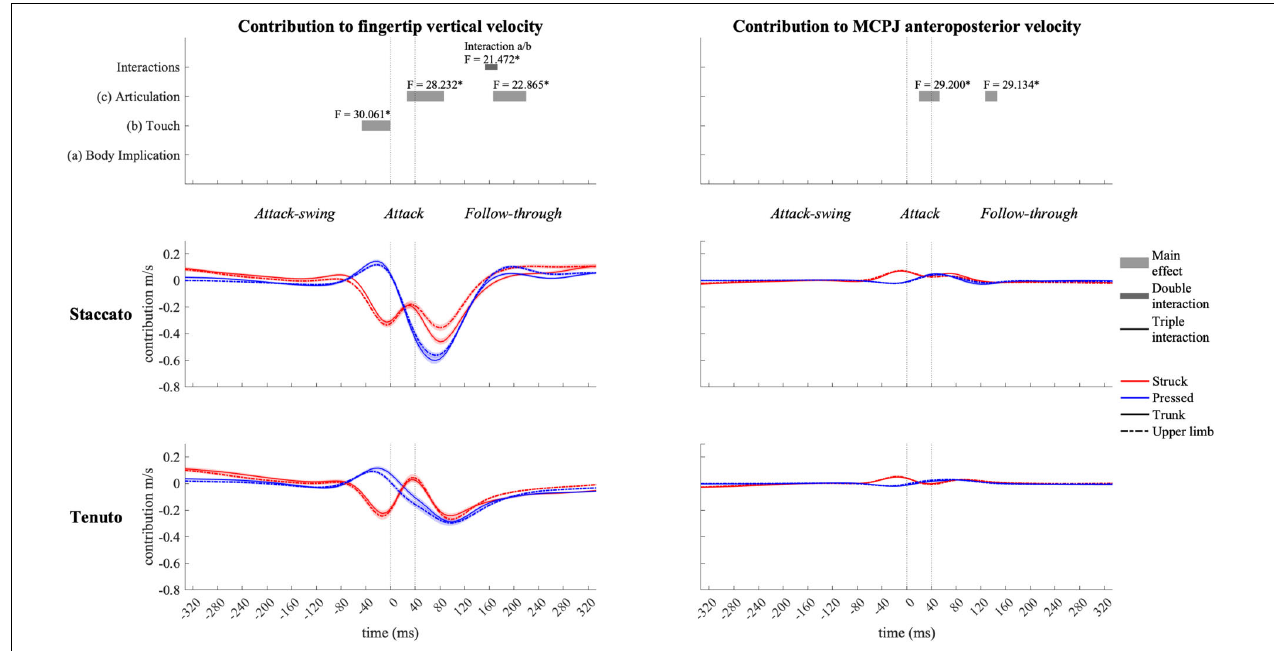
FIGURE 12 | Mean values (solid and dash-dotted lines) and 95% bootstrap confidence interval (shaded areas) of wrist angular contribution to endpoint velocities during the three phases of the keystroke. Negative/positive values indicate contributions to downward/upward fingertip velocities and to backward/forward metacarpophalangeal joint (MCPJ) velocities. Top panels represent the results from the statistical parametric mapping of time-series values. * p -value ≤ 0.001.